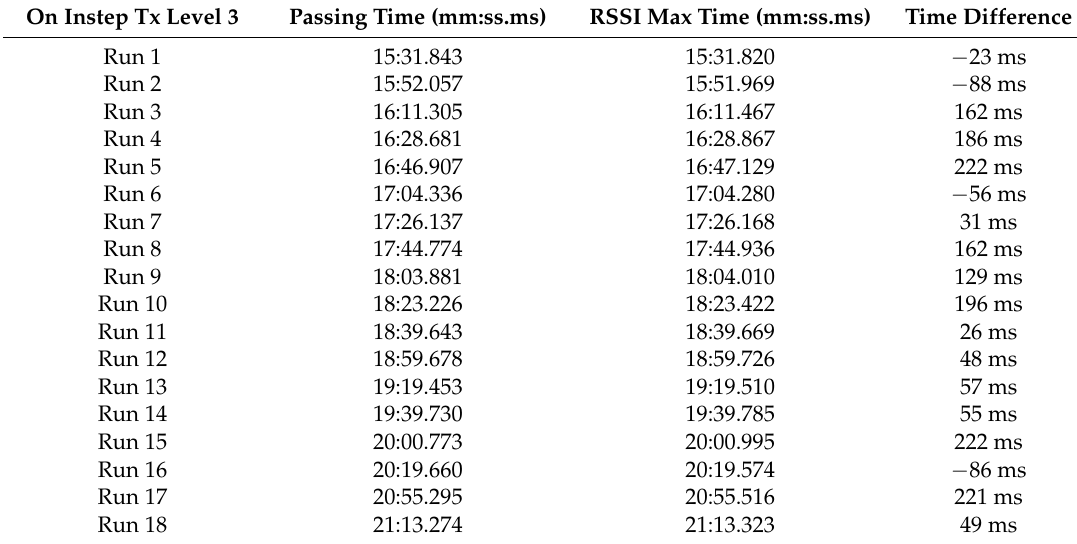
Table 8. The dynamic experiment when the Tx power of the BLE Tag on the instep is set at Level 4. On Instep Tx Level